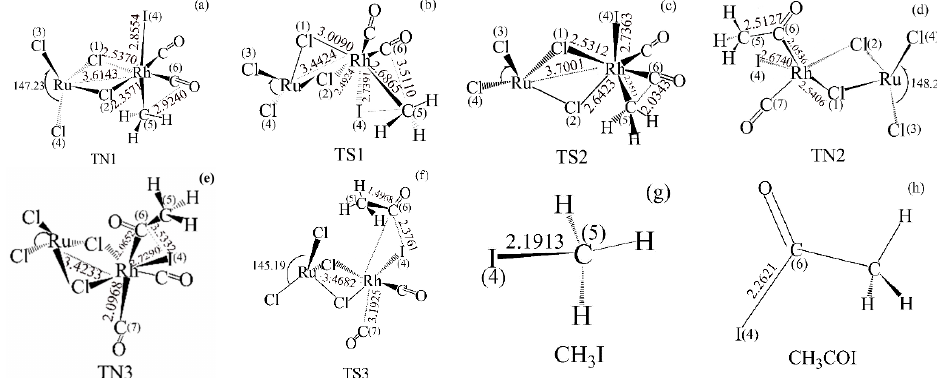
Figure 4. Geometric structure of reactants, transition states, intermediates, and products in methanol carbonylation (bond length in Å, bond angle in degrees): ( a ) CH 3 I addition reaction product (TN1); ( b ) CH 3 I addition reaction state (TS1); ( c ) ligand migration reaction state (TS2); ( d ) ligand migration reaction product (TN2); ( e ) CO addition reaction product (TN3); ( f ) CH 3 COI reductive elimination reaction state (TS3); ( g ) CH 3 I; ( h ) CH 3 COI; (DFT, B3LYP/Lanl2dz).